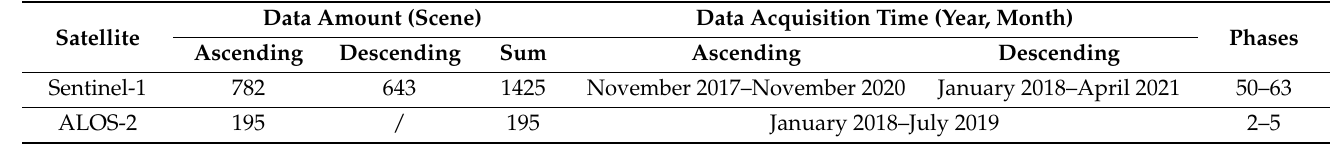
Table 1. Statistics of InSAR data sources in the study area.